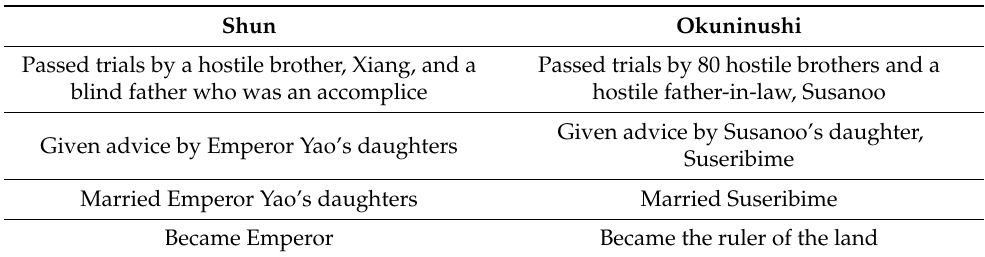
Table 1): Table 1. Shun and Okuninushi.